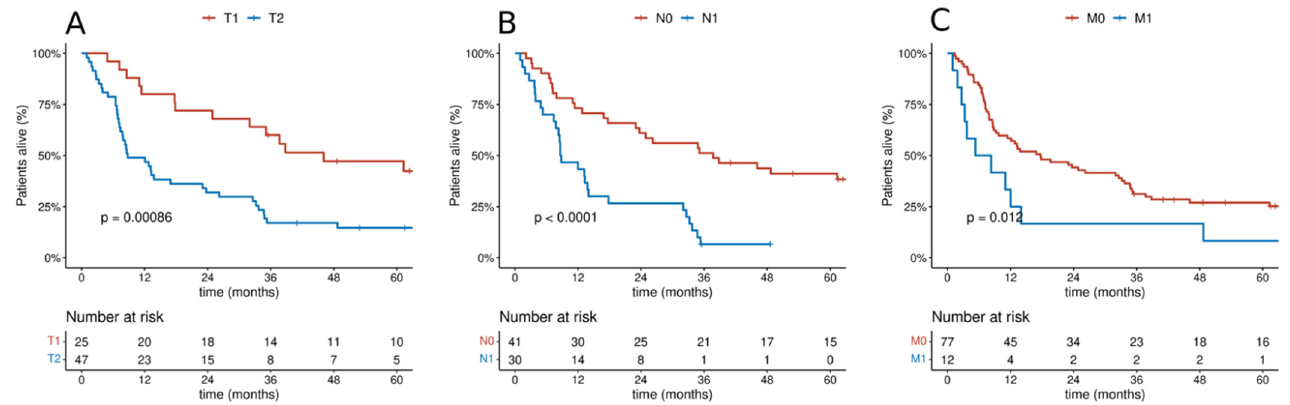
Figure 2. Cumulative probability of overall survival in the entire analyzed group of patients